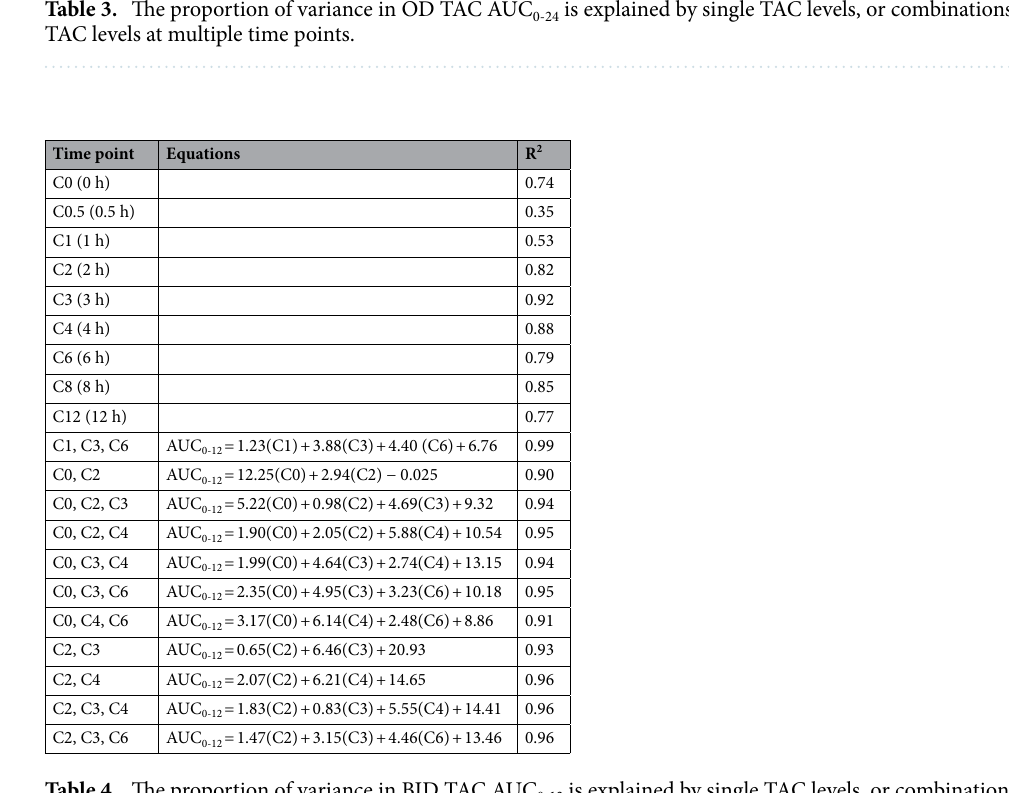
Table 4. The proportion of variance in BID TAC AUC 0-12 is explained by single TAC levels, or combinations of TAC levels at multiple time